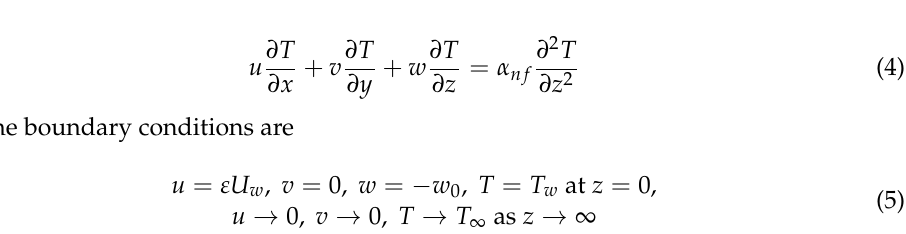
Figure 1. Physical model of the